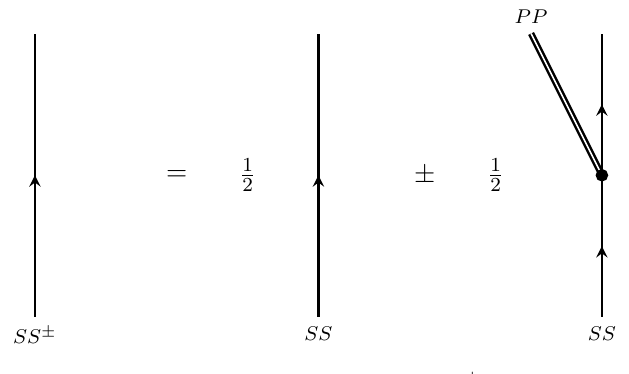
Figure 30 . De(cid:12)nition of SS (cid:6)